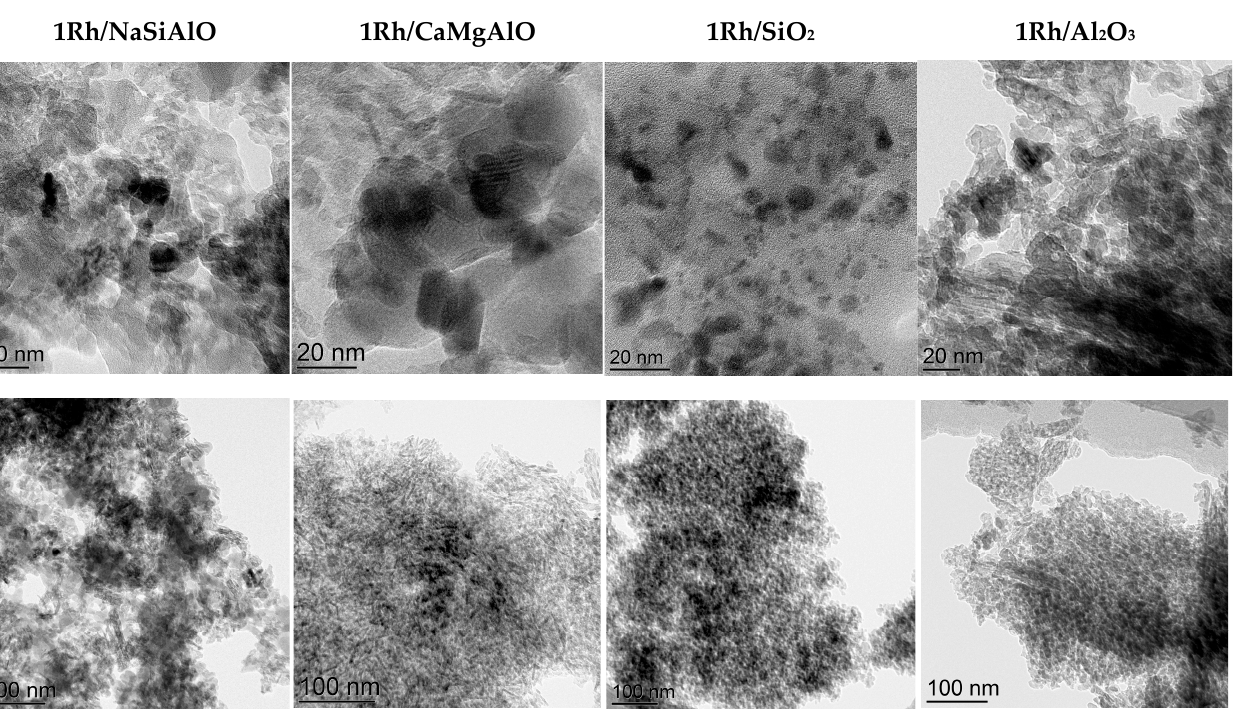
sample 1Rh/NaSiAlO were 0.36, 0.22, and 0.23 nm for the different areas on the TEM image.